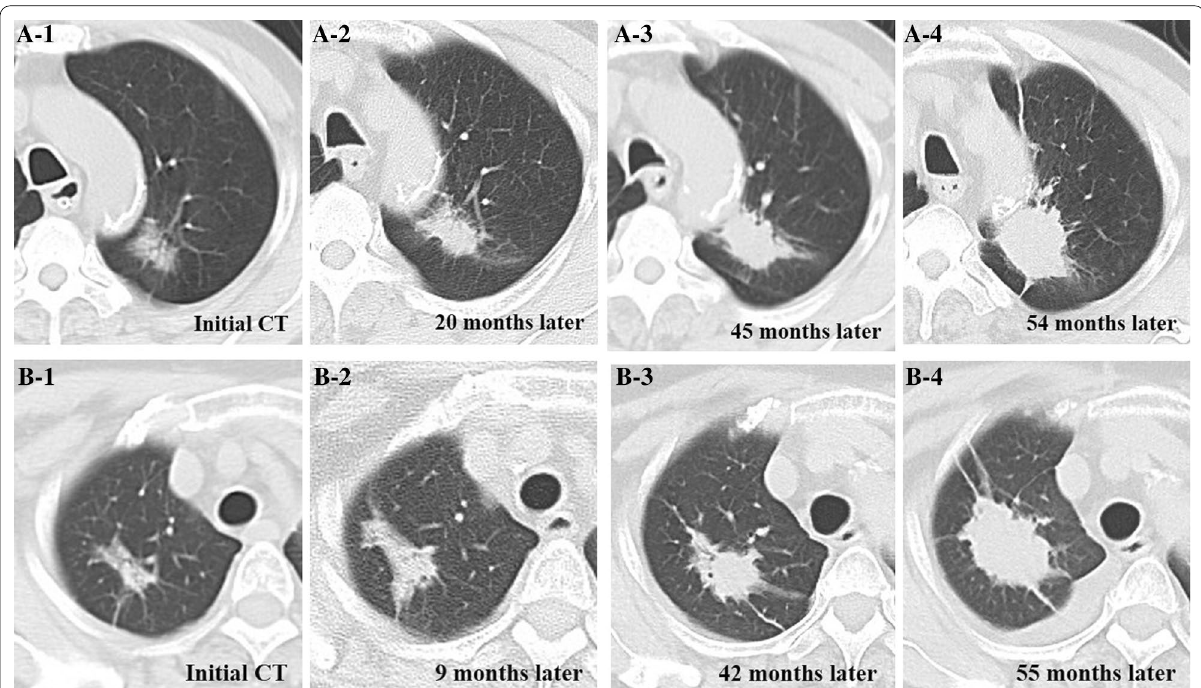
Fig. 6 Morphological evolution of L‑PLADC during follow‑up CT in an 83‑year‑old man ( A ) and a 72‑year‑old woman ( B ), respectively. A and B The two patients were misdiagnosed as pulmonary inflammatory lesion on initial CT. Sequential CT images of the lung window indicate enlarged focal consolidation, increased attenuation, gradual disappearance of air bronchogram and GGO component; eventually, the focal consolidation became a solid mass during